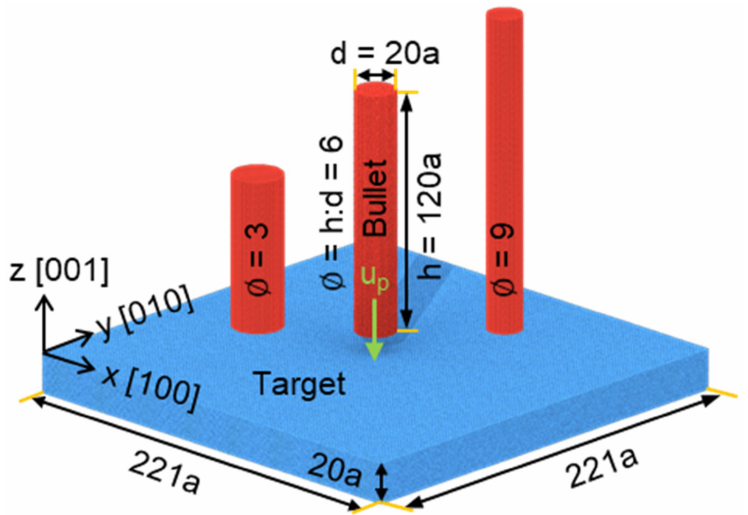
Figure 1. Initial configuration of the target and bullet with different draw ratio. Both the target and bullet are perfect FCC single-crystal aluminum. The atoms are colored by the target (blue) or bullet (red) and represent no physical